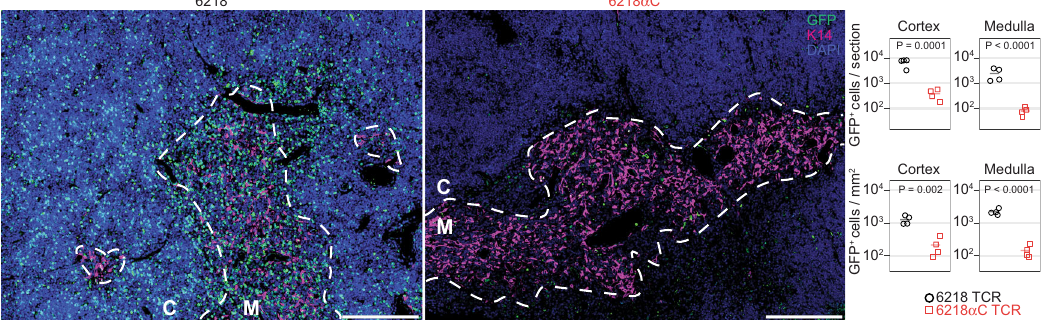
Fig. 2 | Thymic cortical T cell deletion induced by a CDR3 cysteine. TCR- retrogenic mice expressing the 6218 or 6218 α C TCR were made as described in Fig.1,exceptthatallrecipientsweremaleB6mice( n =4for6218; n =4for6218 α C). TCR-retrogenicmicewereanalysed5weeksafterBMtransferat99-138daysofage. Thymus sections were stained for GFP (green), with medullary areas identi fi ed by